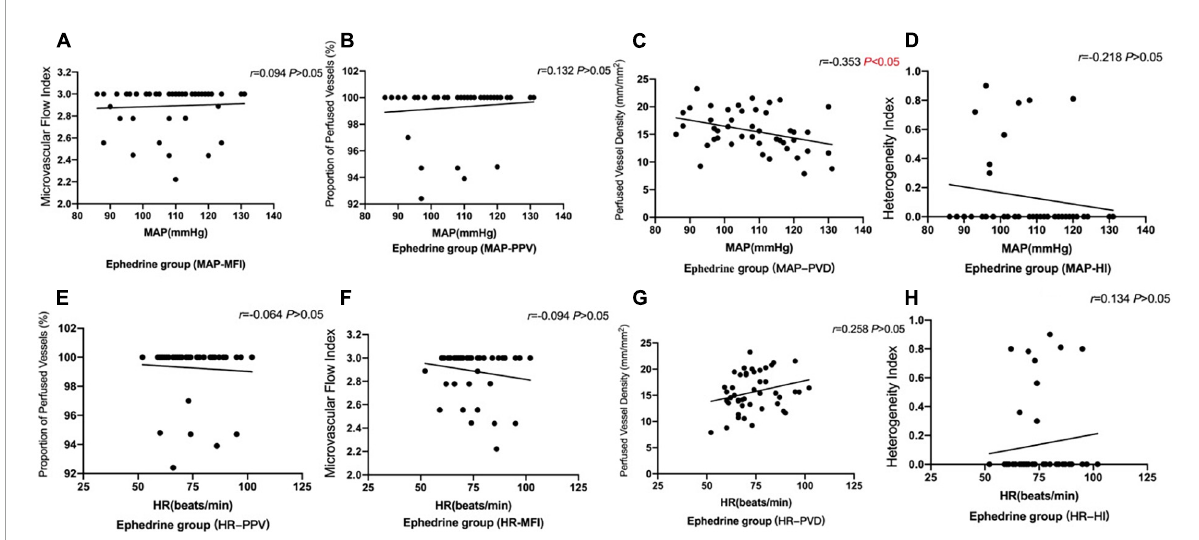
FIGURE6 The correlation of MAP and HR with the microcirculation parameters MFI, PVD, PPV, and HI in the phenylephrine group. MAP was found to have no correlation with microcirculation parameters figures. (A) The correlation of MAP with MFI in the phenylephrine group ( P > 0.05). (B) The correlation of MAP with PPV in the phenylephrine group ( P > 0.05). (C) There is no correlation MAP with PVD in the phenylephrine group ( P > 0.05). (D) There is no correlation MAP with HI in the phenylephrine group ( P > 0.05). (E) There is no correlation HR with MFI in the phenylephrine group ( P > 0.05). (F) There is no correlation HR with PPV in the phenylephrine group ( P > 0.05). (G) There is no correlation HR with PVD in the phenylephrine group ( P > 0.05). (H) There is no correlation HR with HI in the phenylephrine group (P > 0.05).